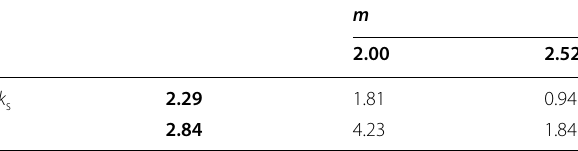
Table 2 The residuals between the estimated thermal structure and the in situ temperature